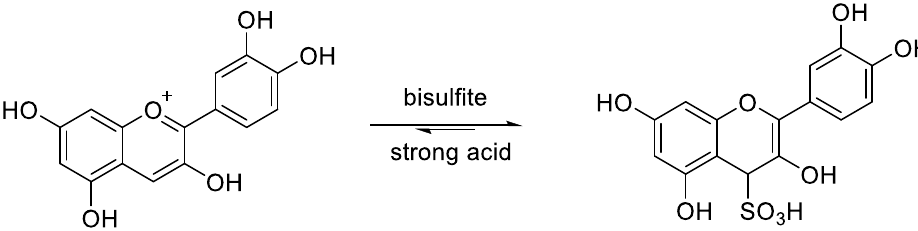
Figure 9. Flavylium cation form (left) and colorless cyanidin–sulfonic acid adduct after bleaching reaction with bisulfite (right).